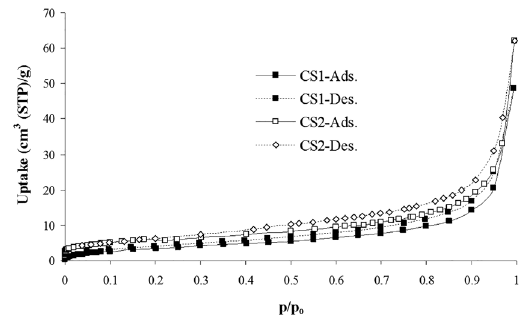
Figure 1: Nitrogen adsorption isotherms at 77 K for CS1 and CS2 samples.